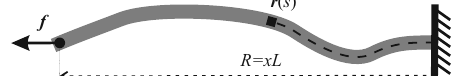
Figure 1. Sketch of a semiflexible filament under a tensile force f , illustrating the notations used in the wormlike chain model and the analysis